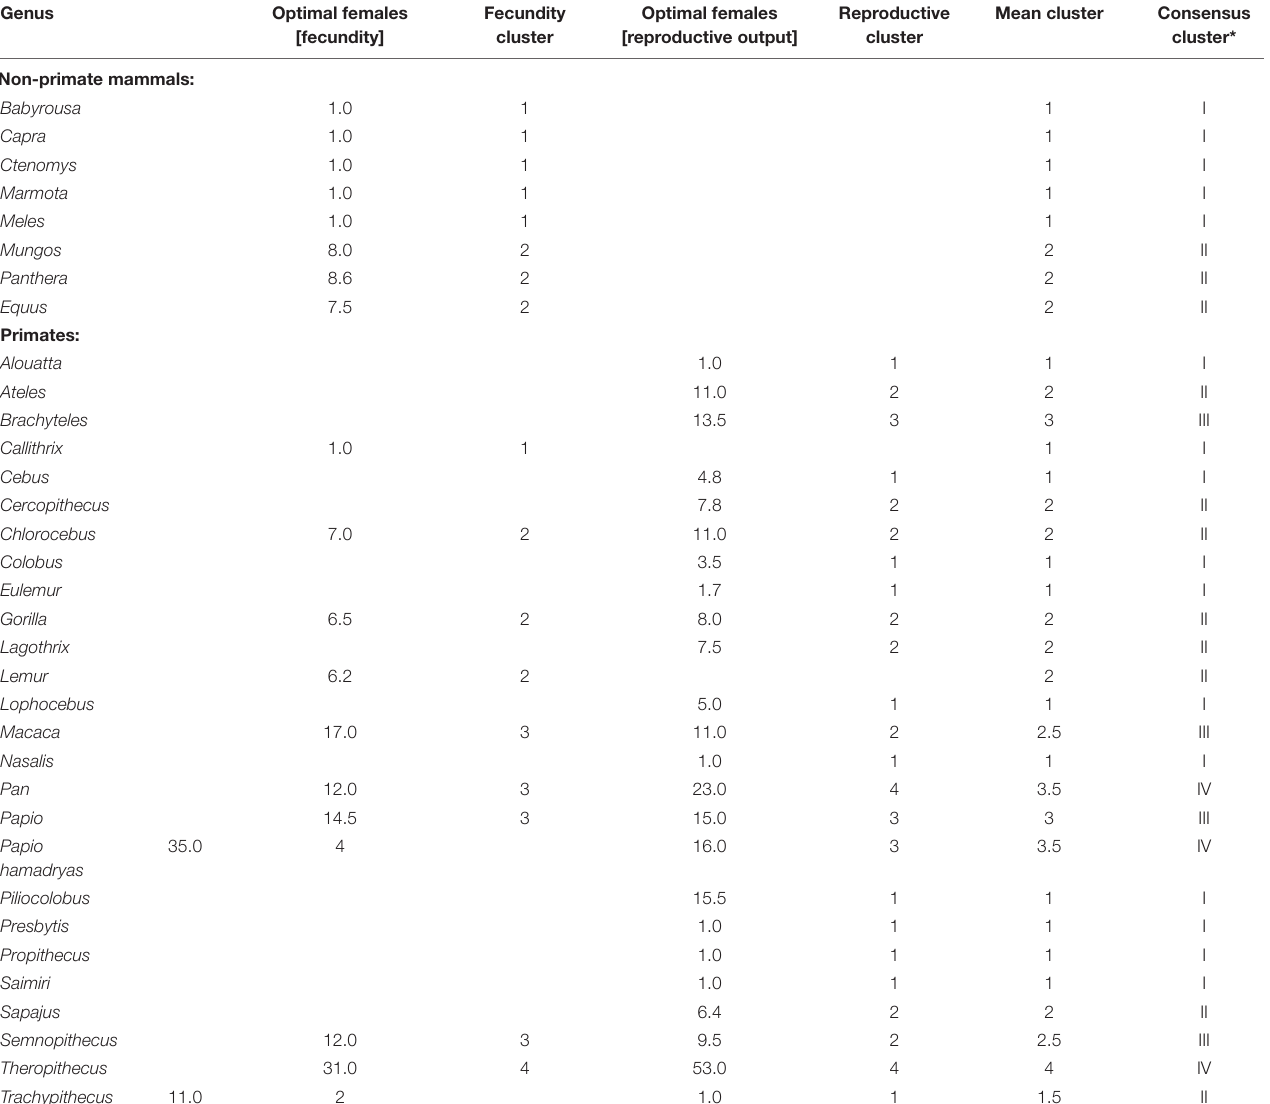
TABLE 1 | Cluster allocations by k -means cluster analysis. Genus Optimal females